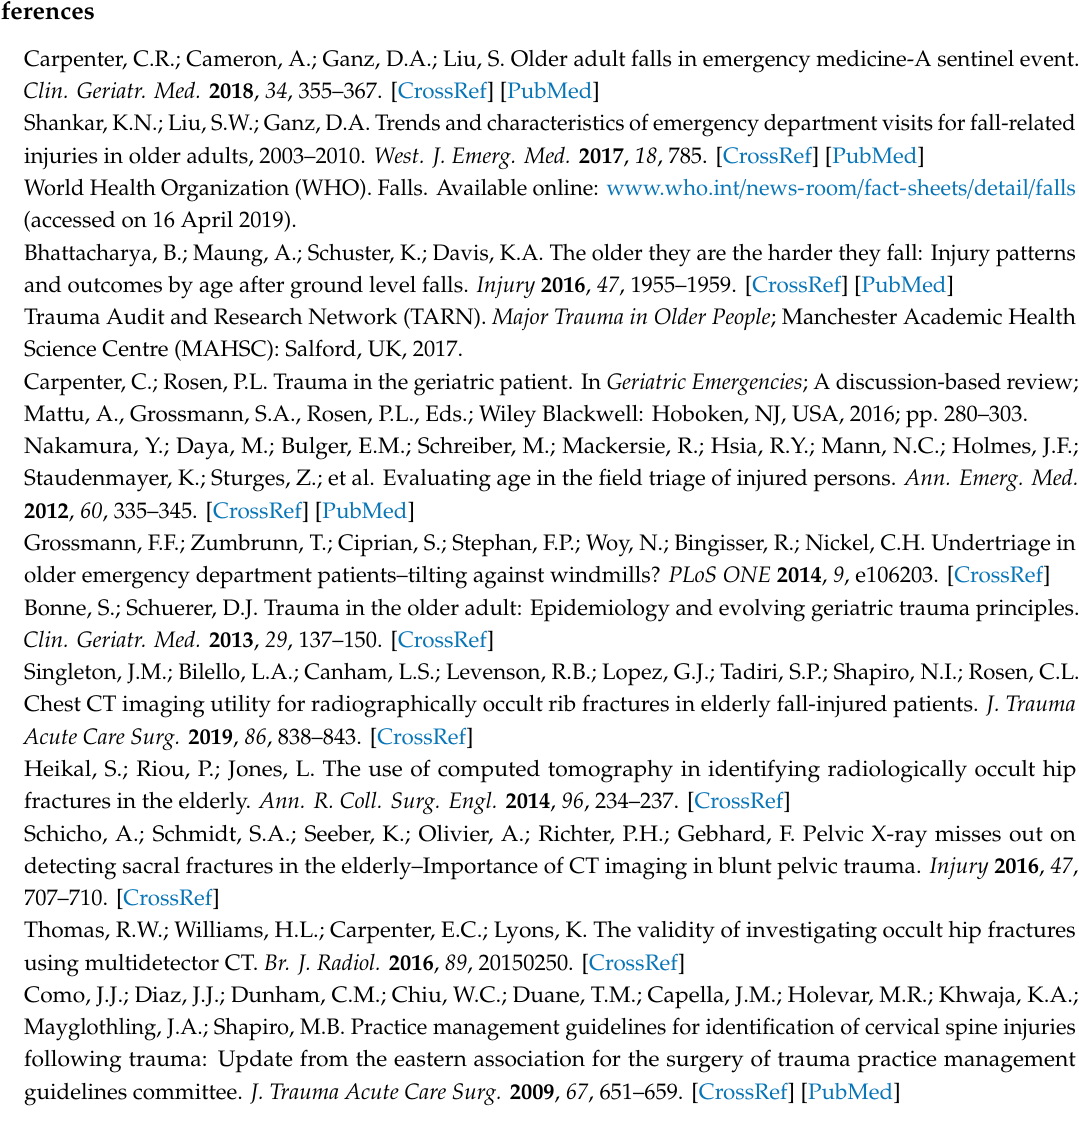
figure designs, to Margareta Kamla and Ceylan Eken for careful language editing and to Christoph Aberle and Joshy Cyriac for providing read-out of the RIS and DICOM databases for DAP and DLP and supporting calculation of radiation